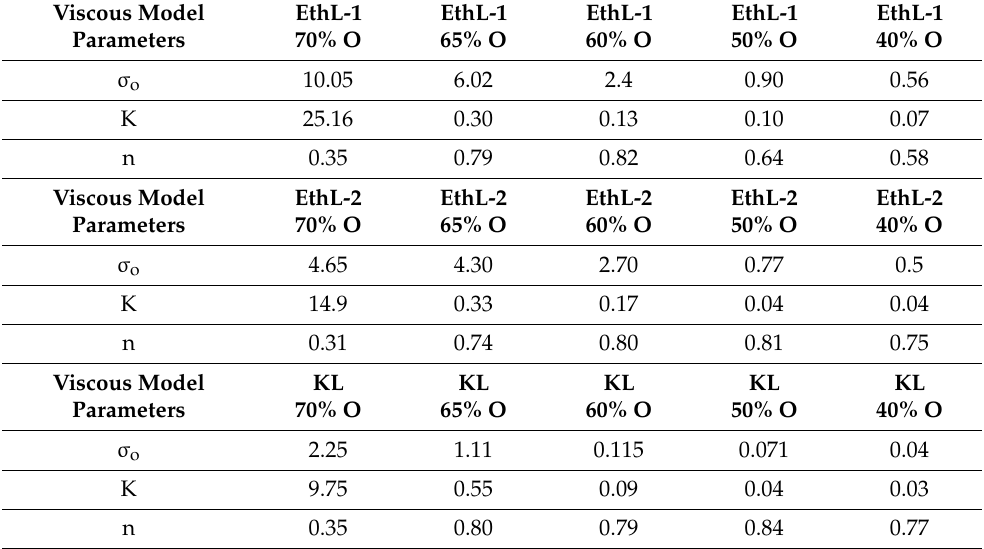
being σ o the apparent yield stress, k the consistency index and n the flow index. Table 1 gathers the values of Herschel ‐ Bulkley parameters calculated for silicone emulsions pre ‐ pared with different oil concentrations.